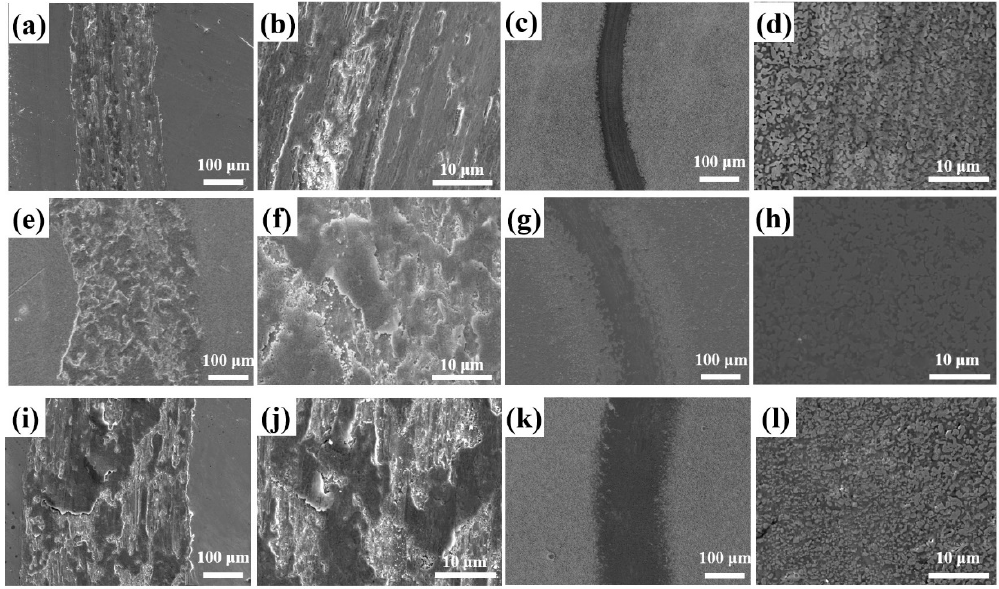
Figure6. Wearmorphologyofweartrackof( a , b )substrateunder0.083m · s − 1 speed, ( c , d )borocarburized Figure 6. Wear morphology of wear track of ( a , b ) substrate under 0.083 m·s − 1 speed, ( c , d ) layer under 0.083 m · s − 1 speed, ( e , f ) substrate under 0.167 m · s − 1 speed, ( g , h ) borocarburized layer borocarburized layer under 0.083 m·s − 1 speed, ( e , f ) substrate under 0.167 m·s − 1 speed, ( g , h ) under 0.167 m · s − 1 speed, ( i , j ) substrate under 0.333 m · s − 1 speed, ( k , l ) borocarburized layer under borocarburized layer under 0.167 m·s − 1 speed, ( i , j ) substrate under 0.333 m·s − 1 speed, ( k , l ) 0.333 m · s − 1 borocarburized layer under 0.333 m·s − 1 speed.